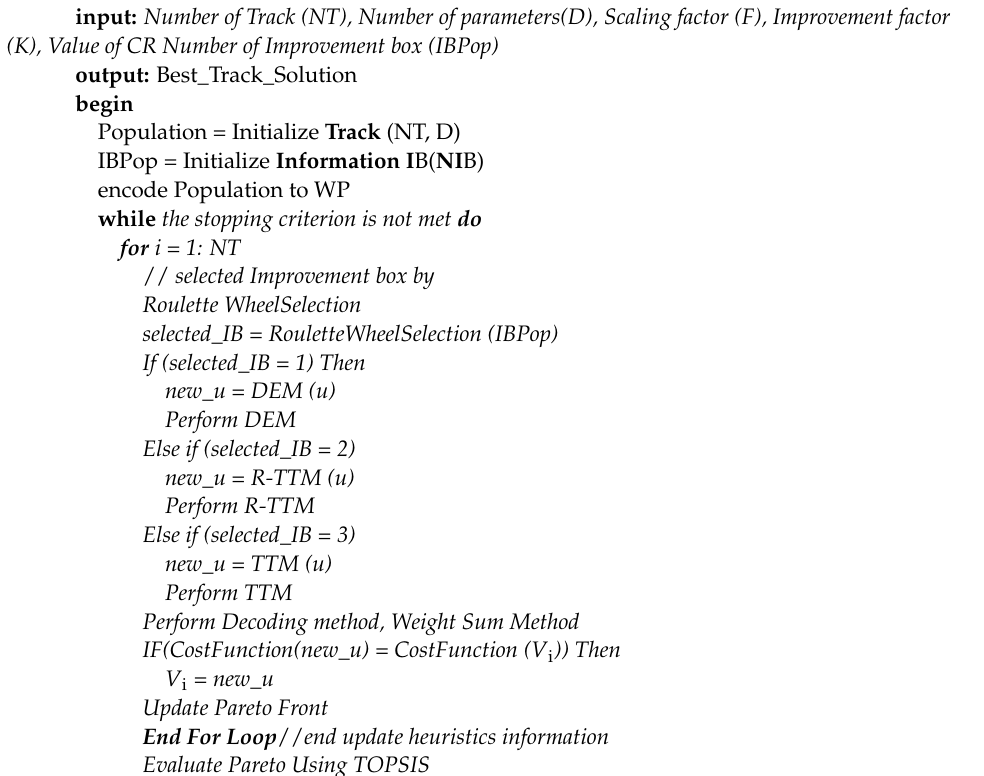
Algorithm 1: Mulit Objective Variable Neighborhood Strategy Adaptive Search